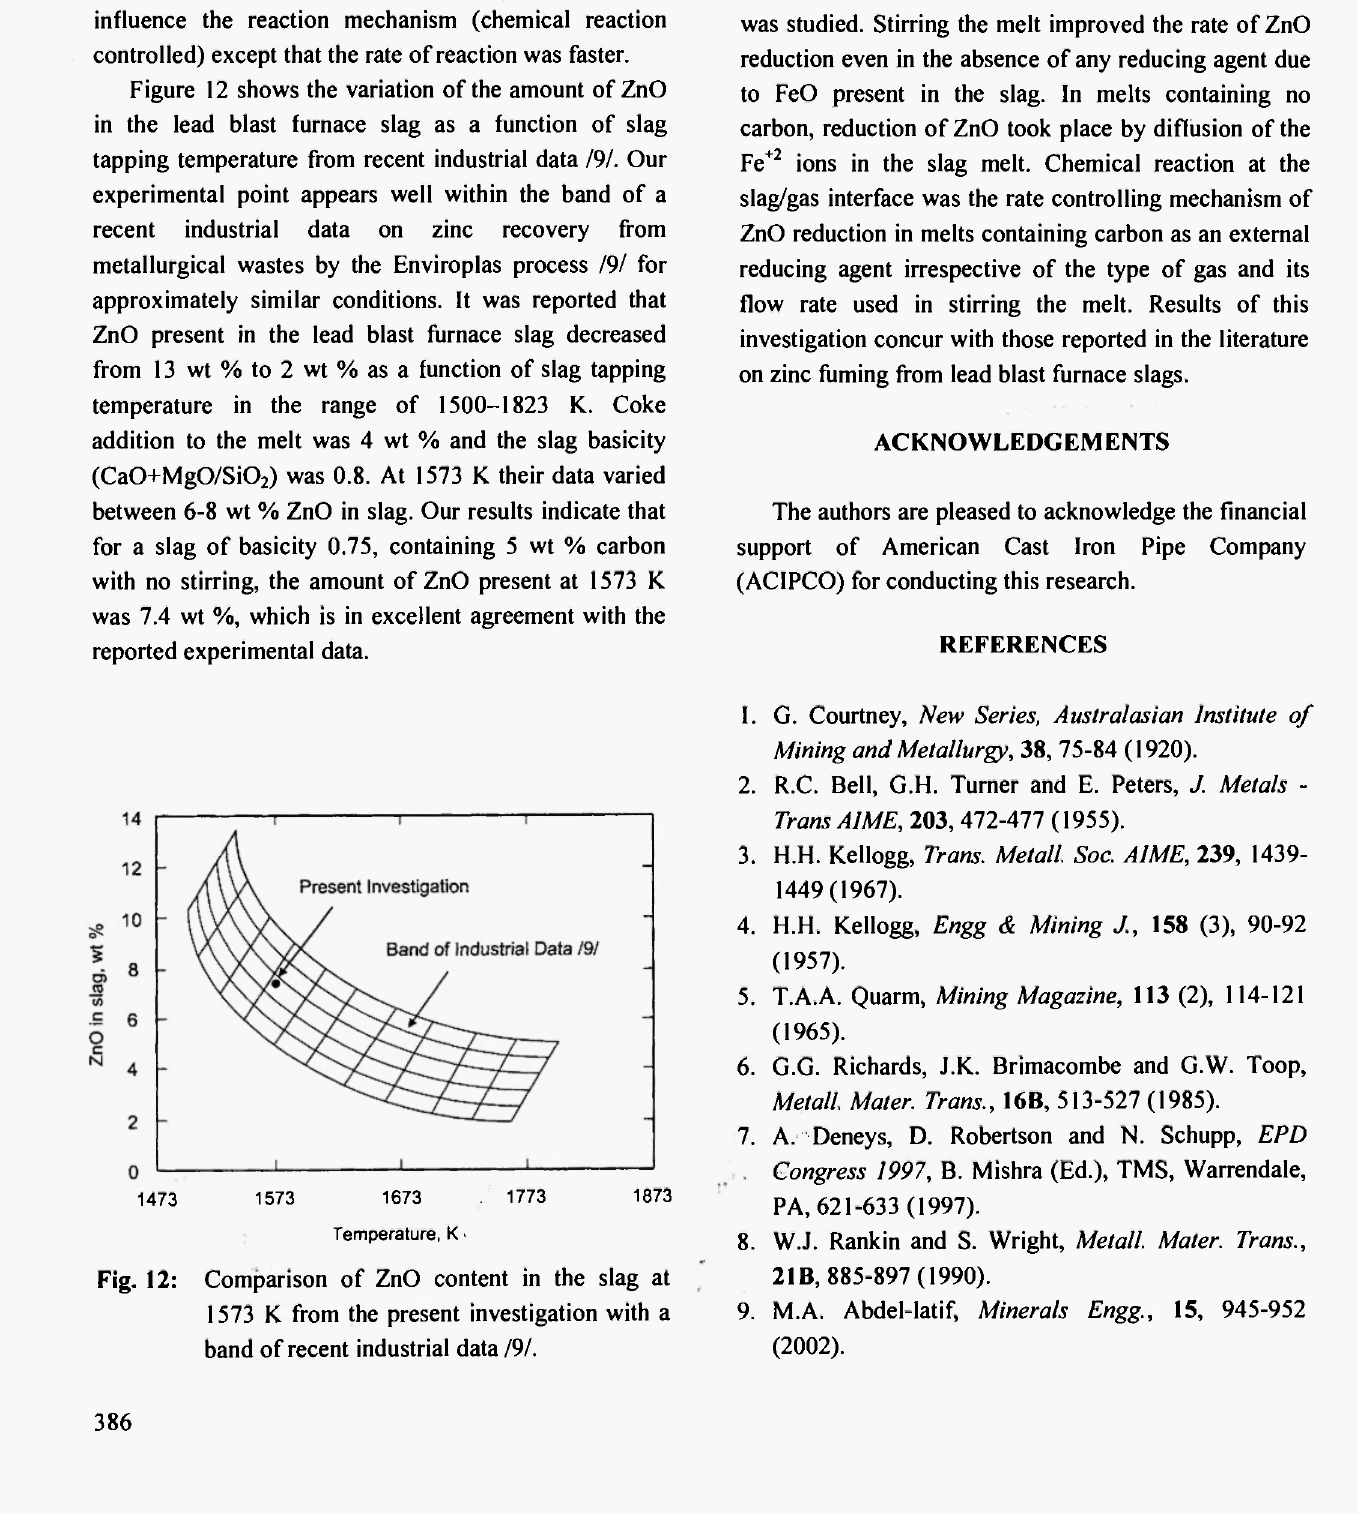
Fig. 12: Comparison of ZnO content in the slag at 1573 Κ from the present investigation with a band of recent industrial data